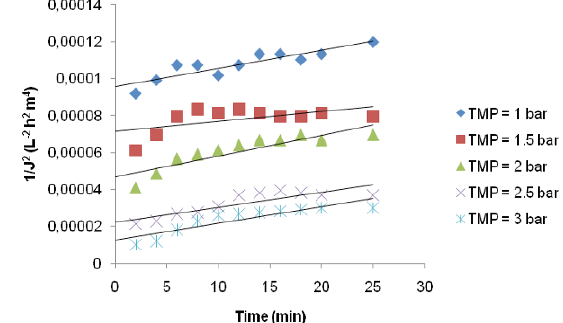
Figure 6. Permeate flux predicted by the cake layer formation mode.